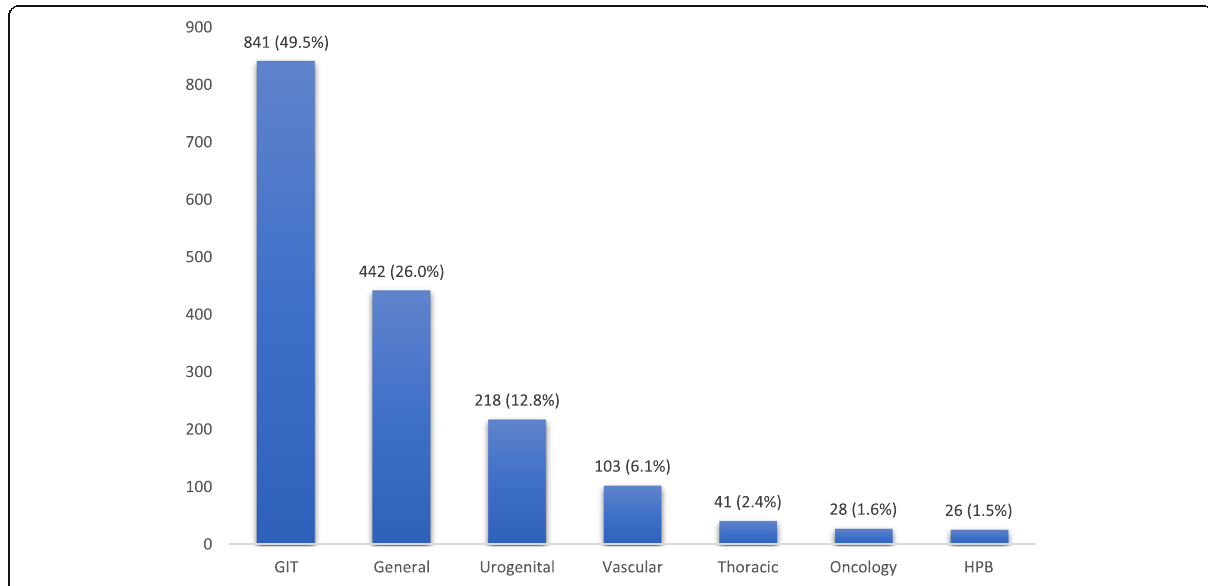
Fig. 4 The most common paediatric surgical procedures per